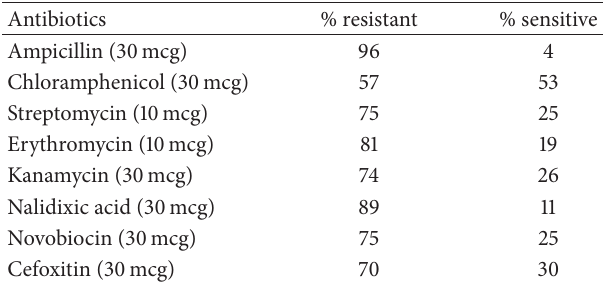
Table 5: Susceptibility and resistance pattern of Staphylococcus aureus to 8 antimicrobial agents.